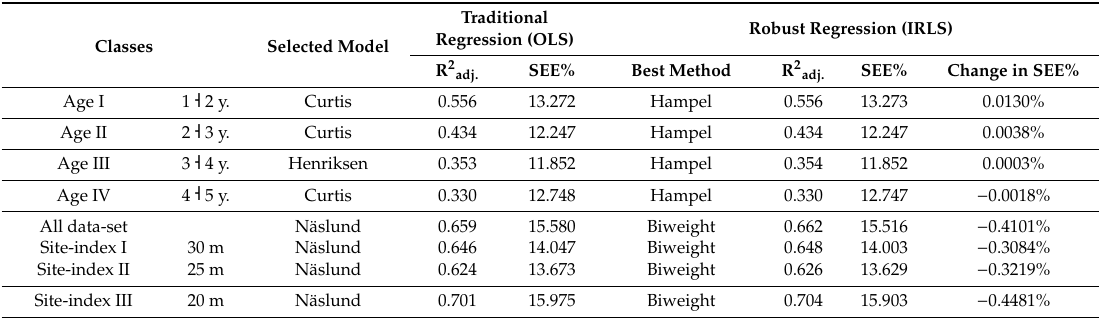
Table 1. Descriptive statistics of height–diameter variables in the fit and validation data-sets of Ochroma pyramidale (balsa-tree) trees by site-index and age classes in Ecuador.